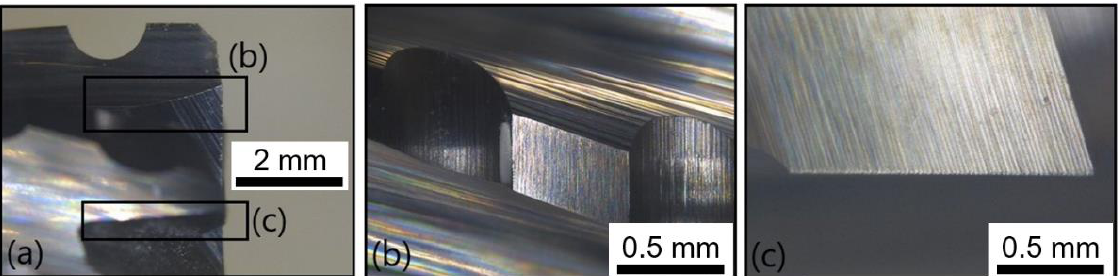
Figure 17. T2: Lateral view at the fresh state: ( a ) global view of the end-mill, ( b ) zoom on a clearance face and ( c ) zoom on another clearance face.